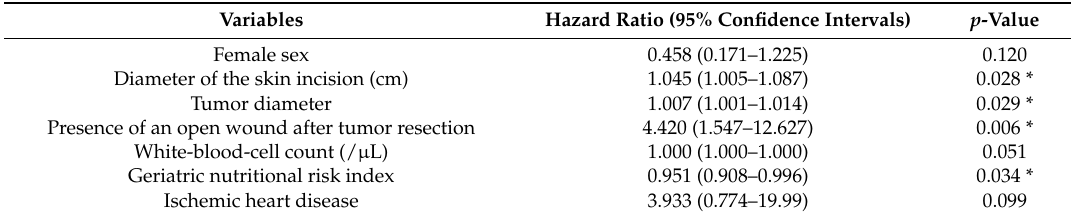
Table 6. Binomial logistic regression analysis of the risk factors for surgical site infection (SSI) after